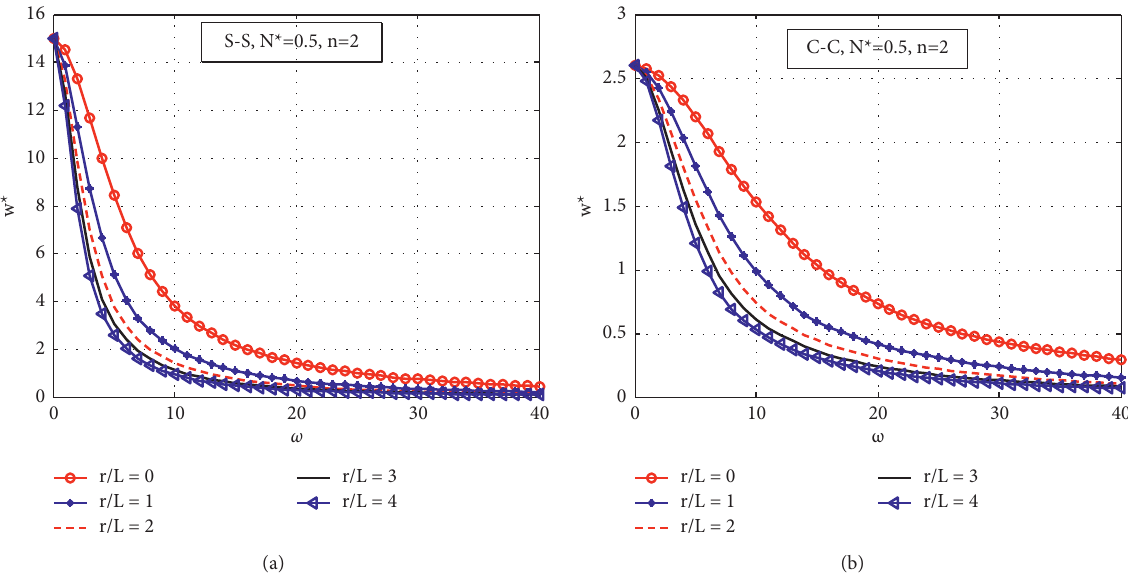
Figure 3: The nondimensional maximum deflection of the FG beam as a function of rotating speed and (r)/(L) ratio, K ∗ α � 0.2. (a) S-S. (b) C-C.